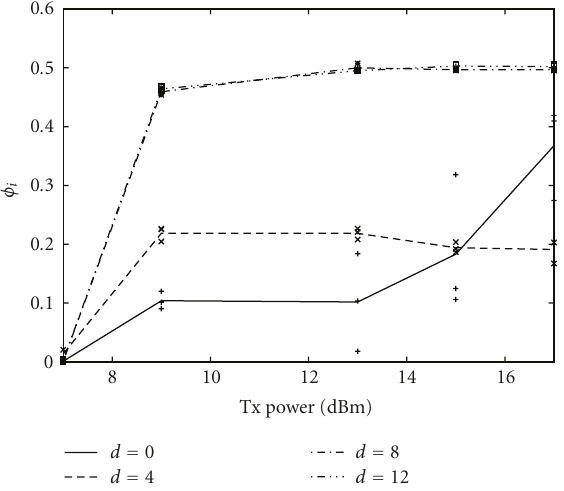
Figure 17: Impact of channel separation and transmitted power on bandwidth share.